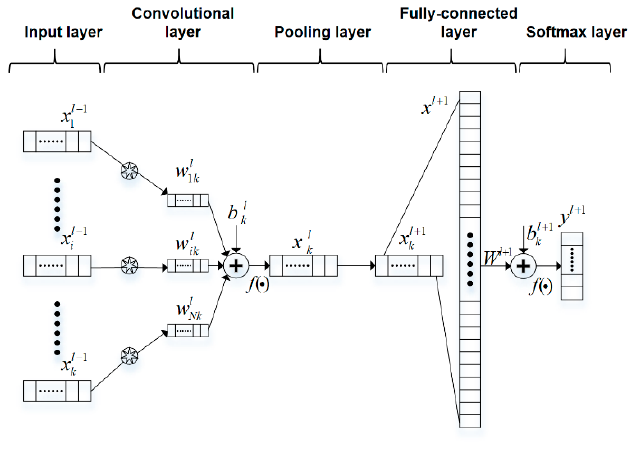
Figure 1. The principle of 1-D convolutional neural networks.